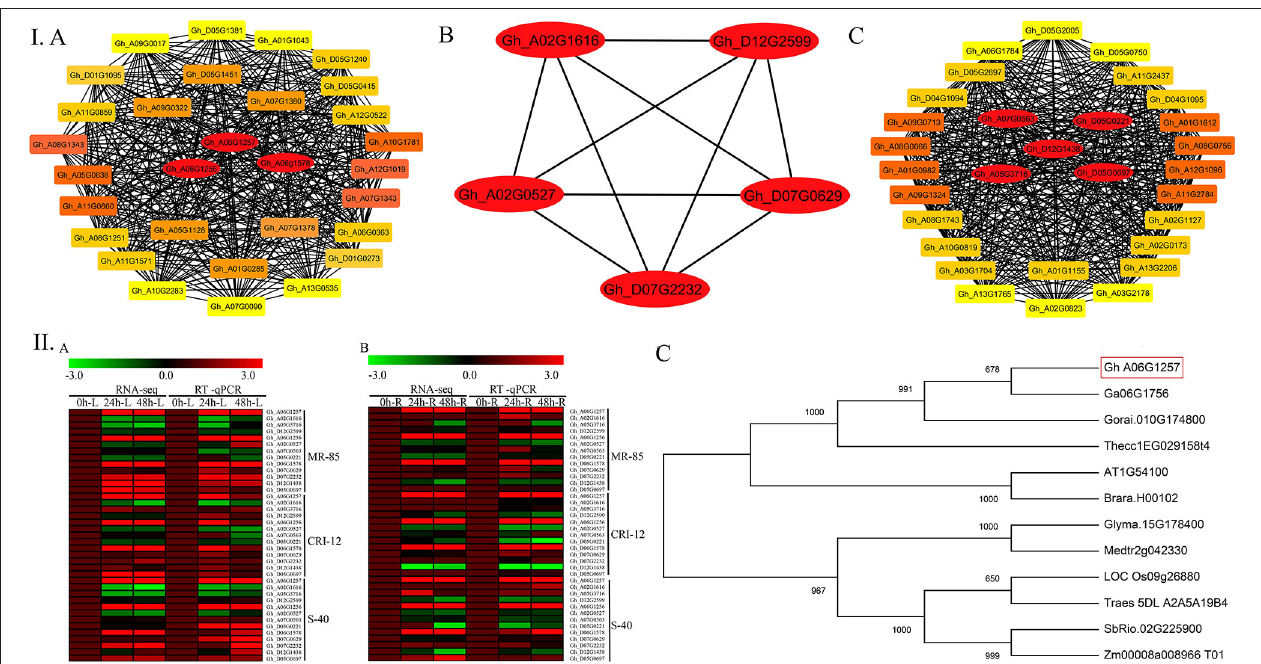
FIGURE 4 | Hub genes identification for drought stress tolerance and RT-qPCR analysis. (I) A Brown module, B Pink module, C Yellow module. (II) Gene expression in the cotton accessions is represented as a heat map. A Heat map of RNA Seq (FPKM) and RT-qPCR of leaf tissues in log2 fold change. B Heat map of RNA Seq (FPKM) and RT-qPCR (RT-qPCR) of root tissues in log2 fold change. C Phylogenetic tree analysis for homologous genes. FPKM, Fragments per kilobase of transcript per million fragments; RT-qPCR, Real time quantitative polymerase chain